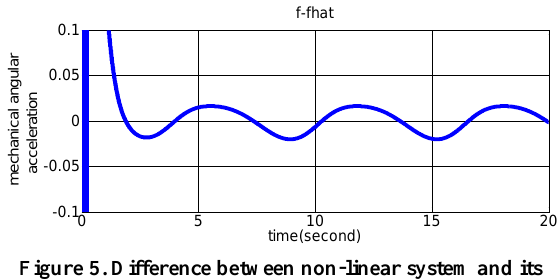
Figure 5. Difference between non-linear system and its fuzzy estimation.